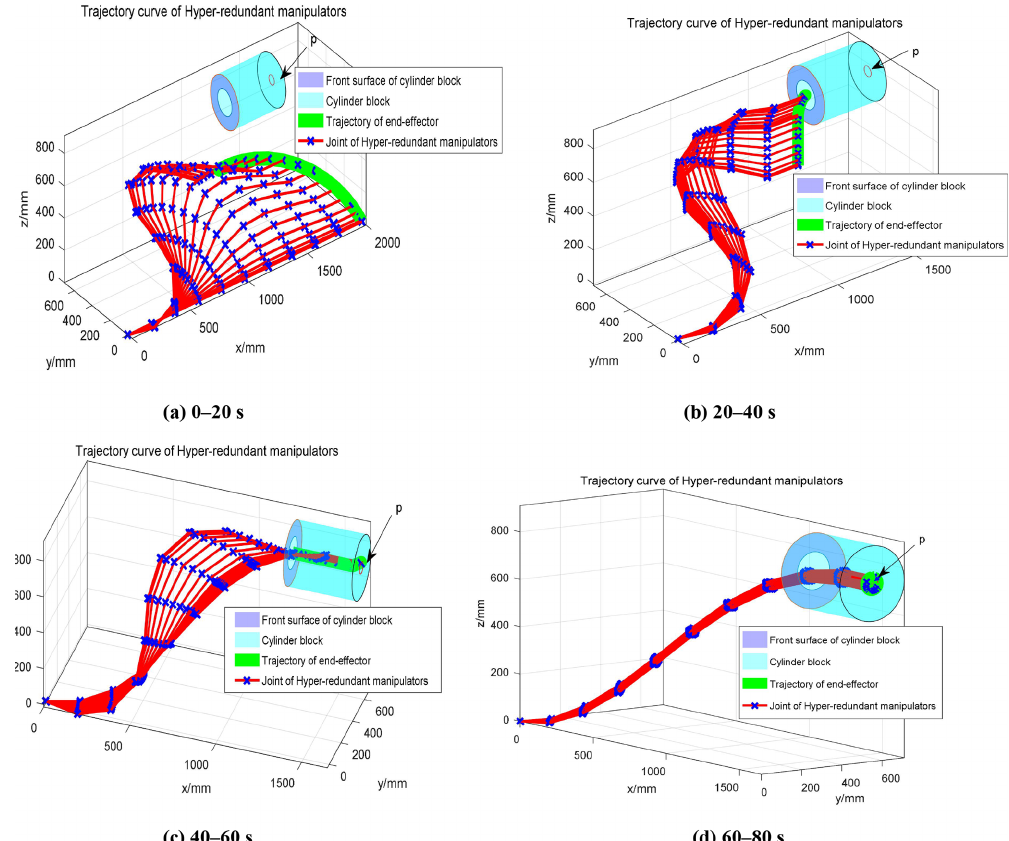
Figure 12. Simulation results of trajectory planning for the hyper-redundant